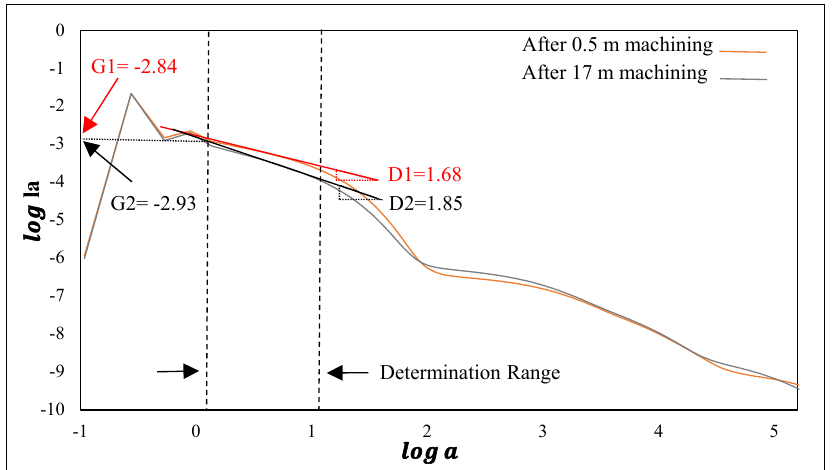
Figure 3. Regularization analysis of the spindle electric current signal. The plot expresses two graphs as an example in log format.